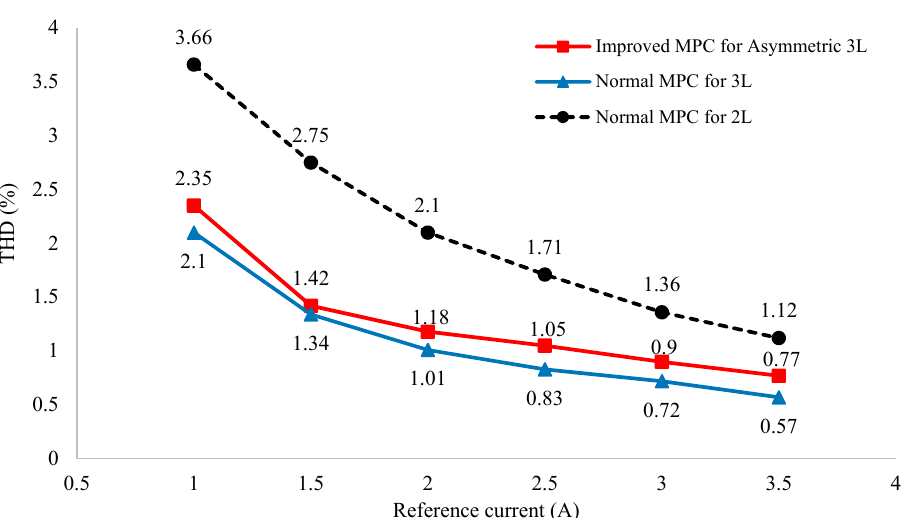
tional 3-level inverter.